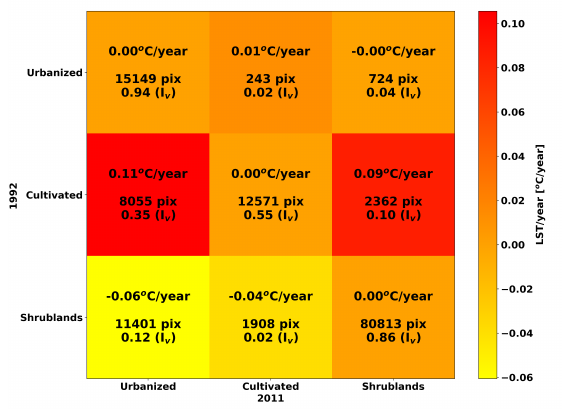
Figure 19. Phoenix MA: Detrended Rate